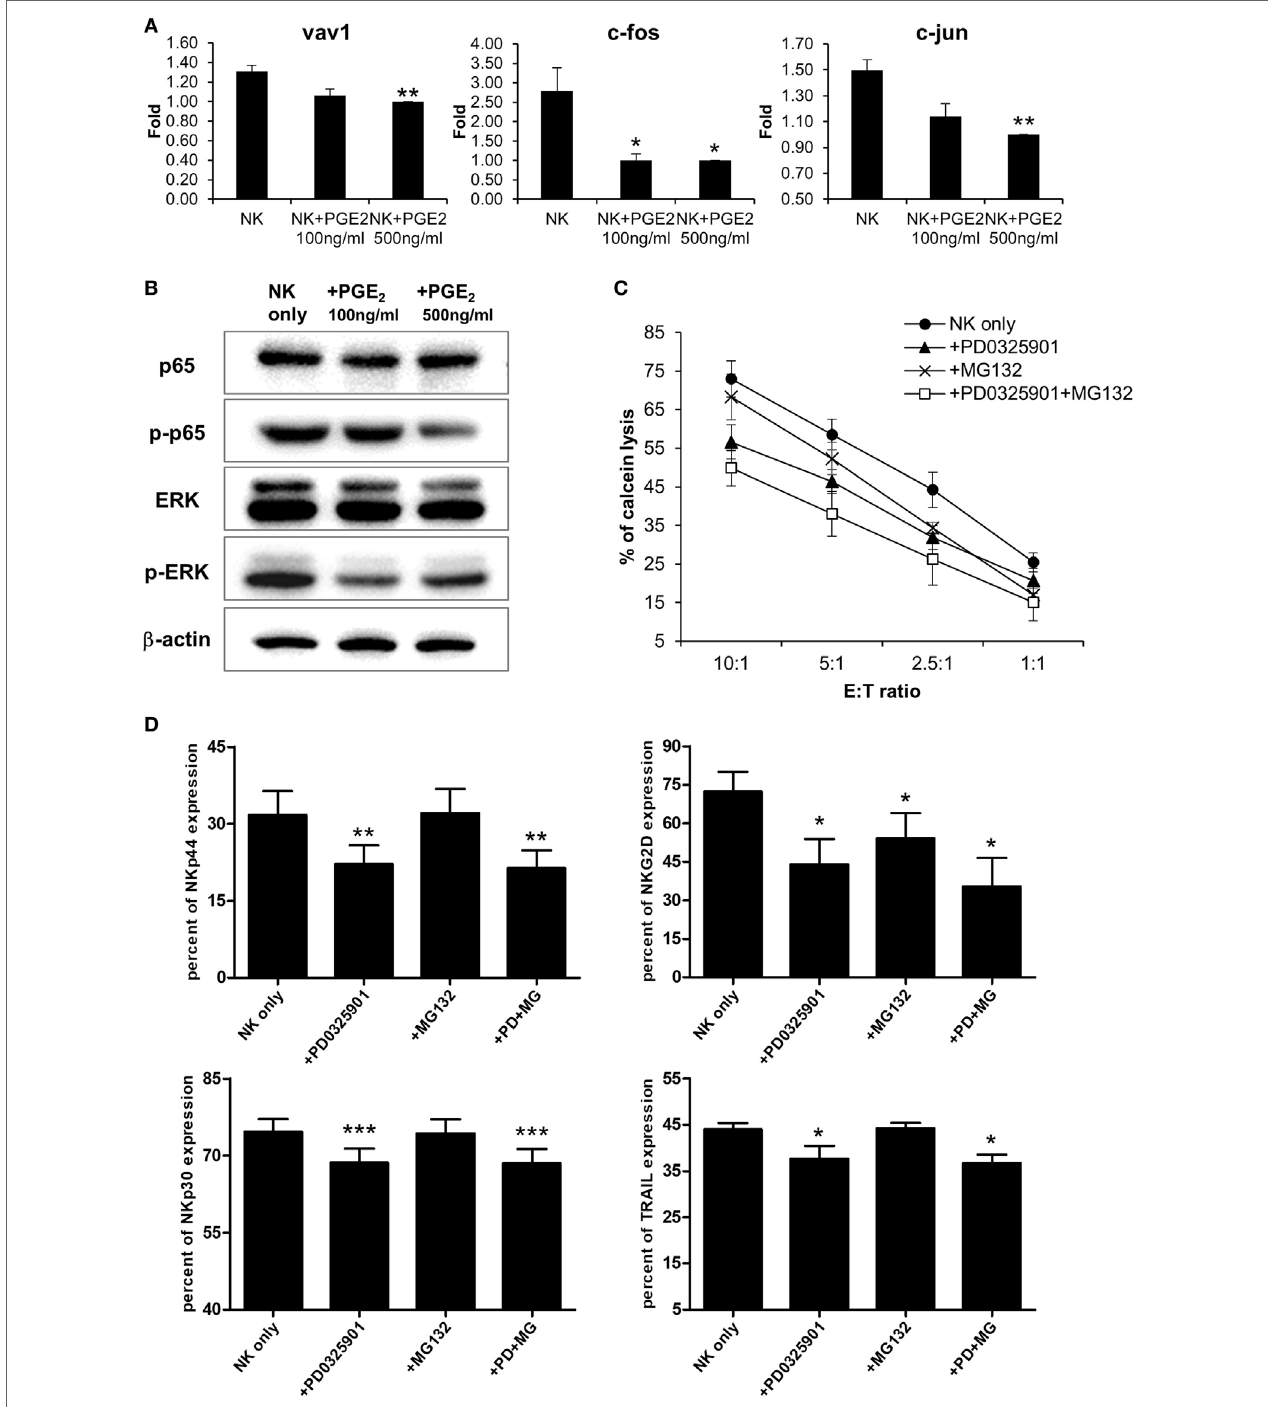
FigUre 5 | PGE2 inhibits natural killer (NK) cell through extracellular signal-regulated kinase (ERK) and p65 signaling pathway (a) mRNA levels of transcription factors related to NK cell functions, as determined by real-time PCR; glyceraldehyde 3-phosphate dehydrogenase served as an internal control. Bars represent mean ± SD of three independent experiments. Statistical analysis was performed using the paired two-tailed Student’s t -test. (B) Detection of components of signaling pathways regulated by PGE2 in NK cells (including ERK and nuclear factor- κ B) by Western blotting; β -actin served as a loading control. (c) NK cells were cultured with IL-2 either in control medium (circle) or in medium containing PD0325901 10 µM (triangle), MG132 1 µM (cross), and both PD0325901 and MG132 (white square) for 48 h. The cytotoxicity of NK cells was assessed against K562 cells at different E:T ratio. Bars represent mean ± SD ( n = 4). (D) Percent of receptor expression was analyzed after gating CD56 + NK cells by flow cytometry. Bars represent mean ± SD ( n = 4). Statistical analysis was performed using the paired one-tailed Student’s t -test. * P < 0.05, ** P < 0.01, and *** P < 0.001.